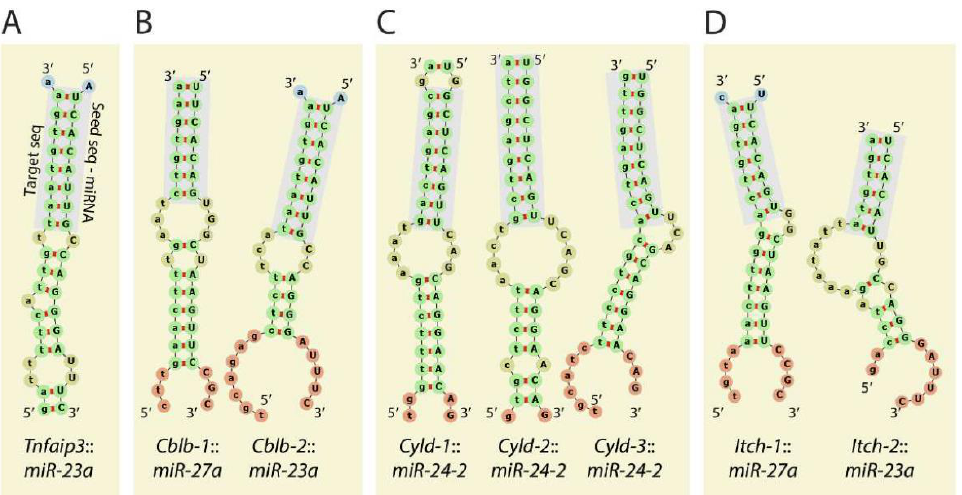
Figure 5. Mirc11 targets members of E3 ligases. The 3′-UTR of the transcripts encoding E3 ligases A20 (TNFAIP3), Cblb, Itch, Cyld contains target sequences for the members of the Mirc11 cluster. ( A ) The 3′UTR of Tnfaip3 contained one seed match for miRNA23a -3p at 1664–1671 nts. ( B ) The 3′-UTR of Cblb contained two seed matches at 3216–3236 and 5879–5901 nts targeted by miR-27a -3p and miR-23a -3p, respectively. However, the role of miR-27a -3p and miR-23a -3p in degrading the Cblb transcript has not been established. ( C ) The 3′-UTR of Cyld contained three sequences at 3842–3864, 4031–4051, and 5979–6000 nts, which were all targeted by miR-24-2 -3p. ( D ) The 3′-UTR of Itch contained two seed matches at 2882–2900 and 4649–4669 nts that were targeted by miR-27a -3p and miR-23a -3p, respectively.